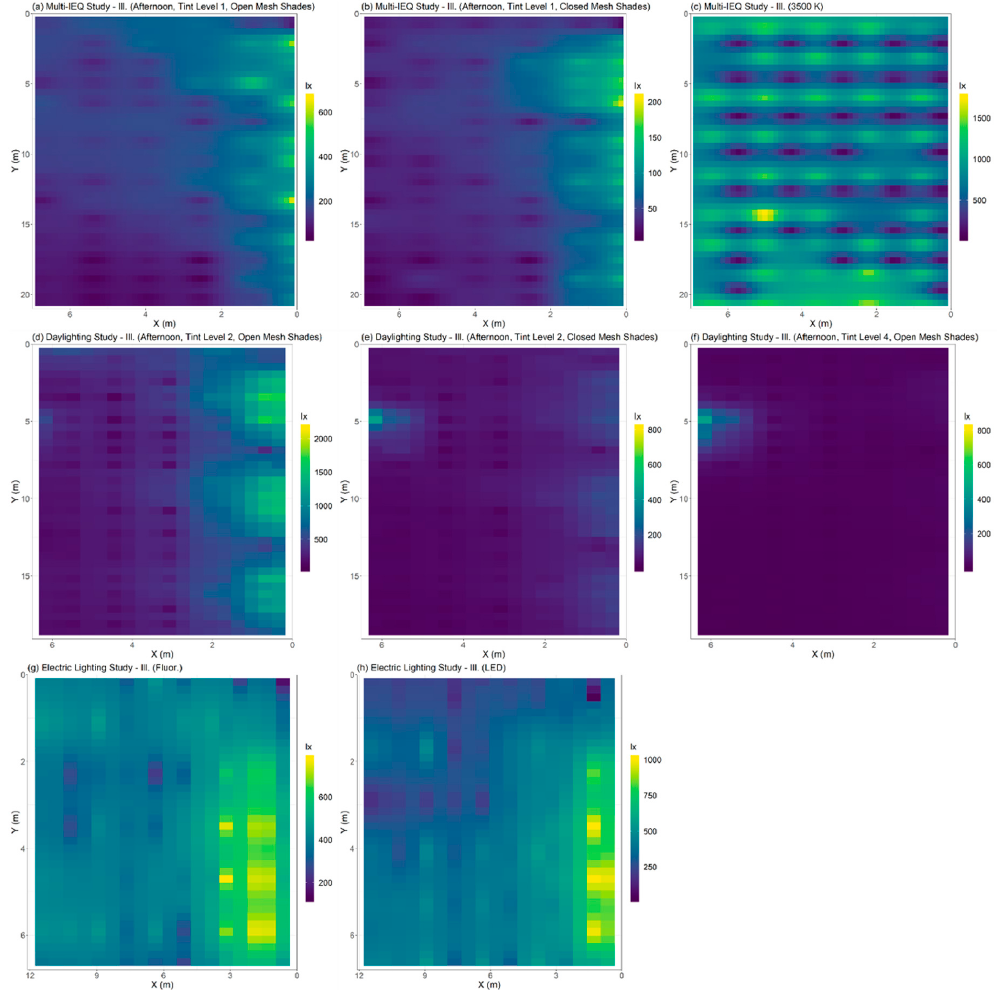
Figure 7. Spatial horizontal illuminance (lx) variability during the multi-IEQ study of ( a ) natural light during afternoon at tint level 1 with mesh shades open, ( b ) natural light during afternoon at tint level 1 with mesh shades closed, and ( c ) electric lighting illuminance (lx) with lamps set to 3500 K. Spatial horizontal illuminance (lx) variability during the daylighting study of ( d ) natural light during afternoon at tint level 2 with mesh shades open, ( e ) natural light during afternoon at tint level 2 with mesh shades closed, and ( f ) natural light during afternoon at tint level 4 with mesh shades open. Spatial horizontal illuminance (lx) variability during the electric lighting study of ( g ) fluorescent lighting and ( h ) LED lighting.